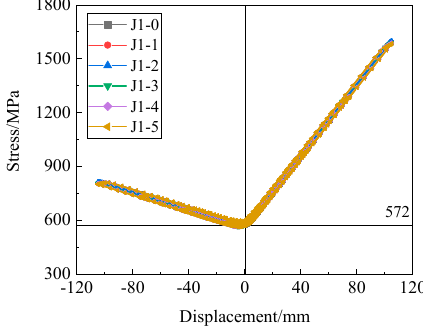
Figure 17. Stress variation curves of steel strands.